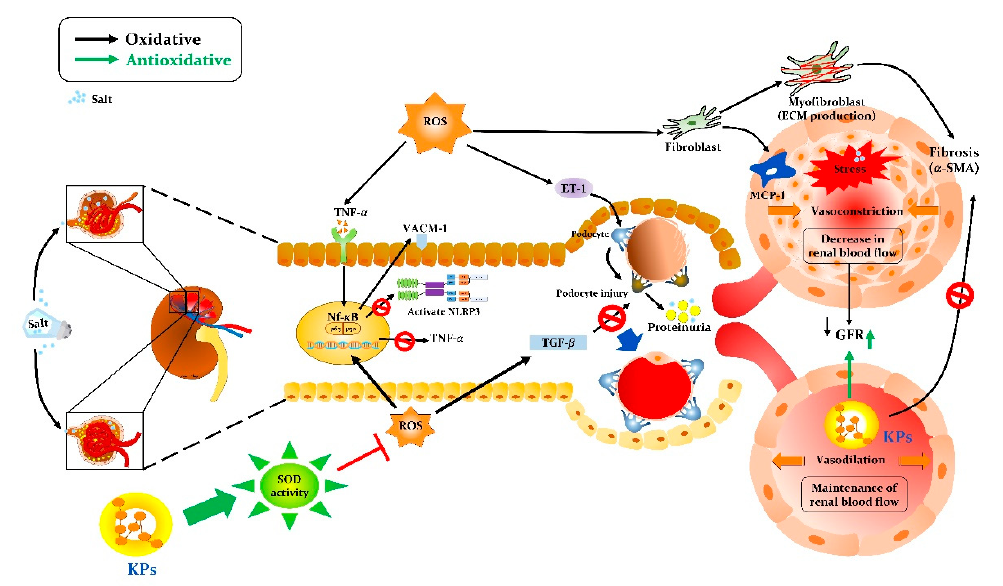
Figure 8. Schematic mechanism by which kefir peptides (KPs) ameliorate salt-induced renal damage and dysfunction in the SHRSP rat model. Kefir peptides may protect against renal damage and dysfunction through their antioxidant function, which increases the SOD activity and reduces ROS accumulation; anti-inflammatory function, which decreases NF- κ B, TNF- α , and NRLP3 inflammatory factors; and antifibrotic function, which inhibits TGF- β , MCP-1, ET-1, and α -SMA generation, attenuating interlobular arterial disorders and maintaining a normal glomerular filtration rate and renal blood flow.